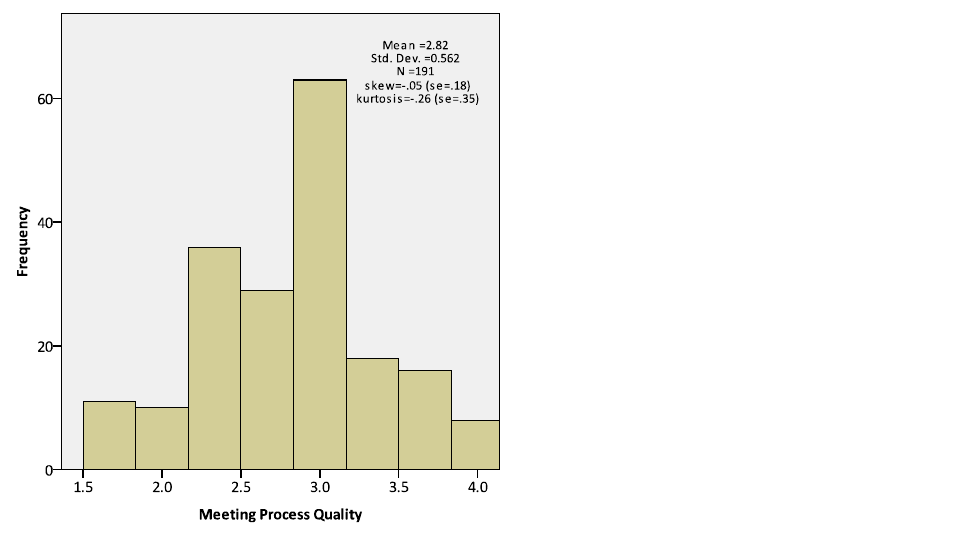
Figure 3 : Distribution of Meeting Process Quality